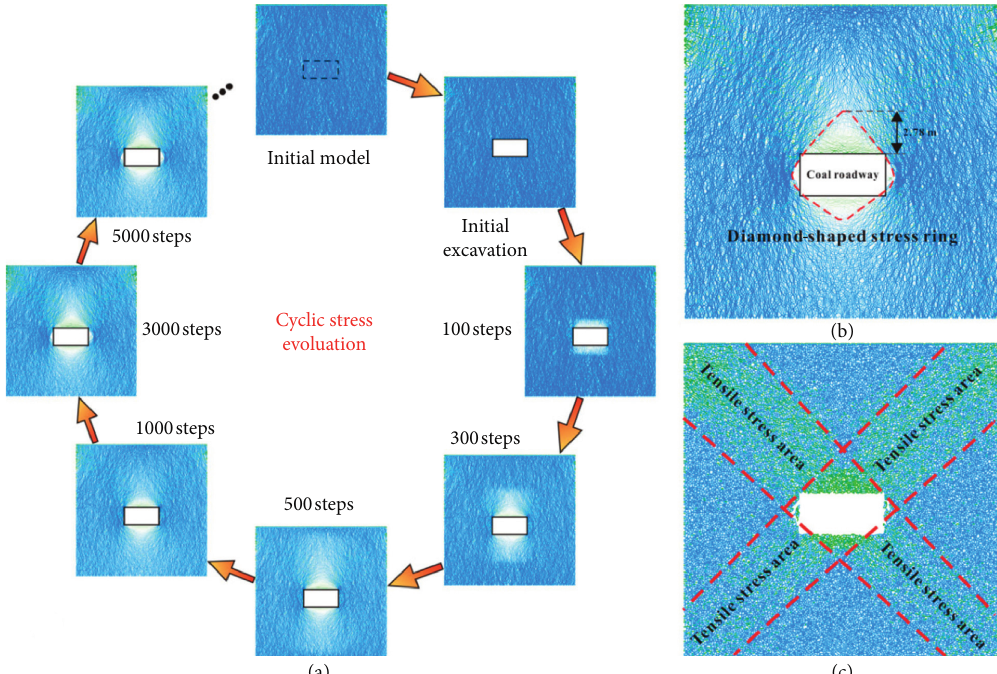
Figure 8: Characteristics of contact forces. (a) The evolution of contact forces. (b) Diamond pattern of contact forces after excavation. (c) X- shaped tensile stress pattern after excavation. The contact forces were greater where the short line of contact force was wider in (a) and (b) and vice versa. (c) The tensile stress and compressive stress are shown as short lines of the same width to show the X-shaped tensile stress zone (blue represents compressive stress and green represents tensile stress).